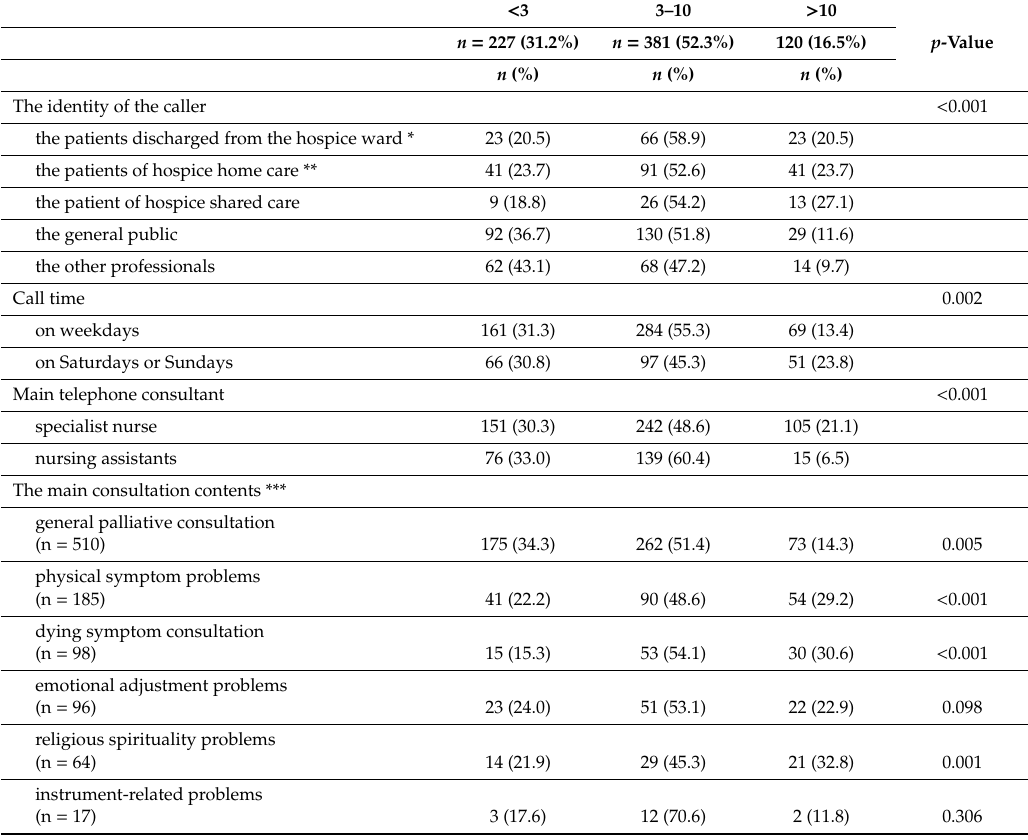
Table 3. Comparison of phone call data and phone call time of 24-hour specialist palliative